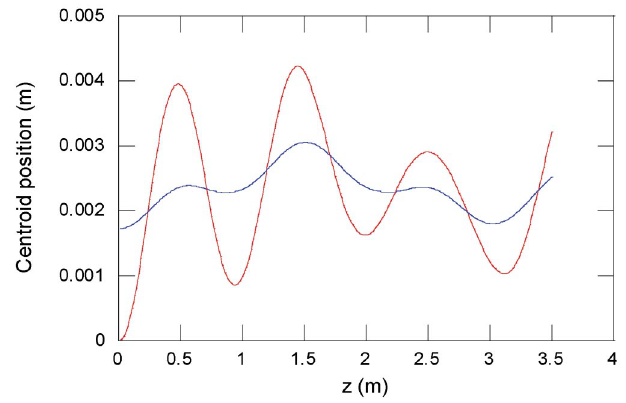
FIG. 13. (Color) Ion-hose calculation in the IFR using method 2, without fractional ionization. The red line shows the electron slice centroid and the blue line shows the ion centroid.